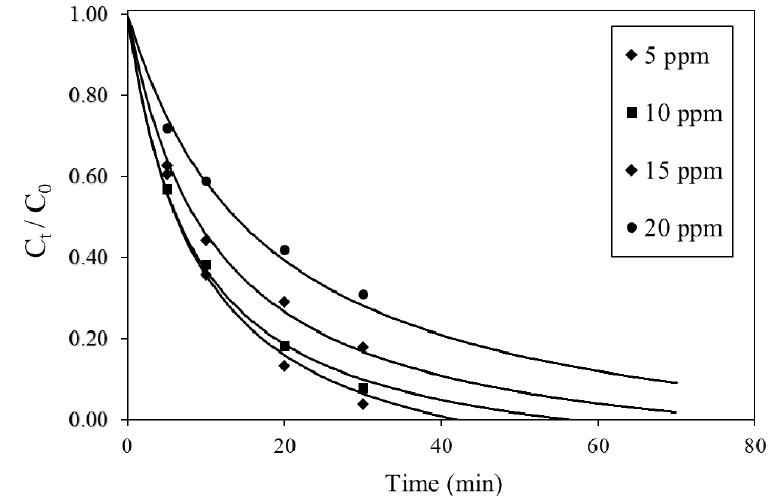
Figure 3. EffectofinitialMBconcentrationonMBadsorption; adsorptionconditions: adsorbentCM-AC-700 Figure 3. Effect of initial MB concentration on MB adsorption; adsorption conditions: adsorbent dosage = 0.3 g / 2 L, adsorption temperature = 25 ◦ C, and agitation speed = 200 rpm; symbols: measurement CM-AC-700 dosage = 0.3 g/2 L, adsorption temperature = 25 °C, and agitation speed = 200 rpm; data, full lines: calculated from the fitted values (Table symbols: measurement data, full lines: calculated from the fitted values (Table 3).